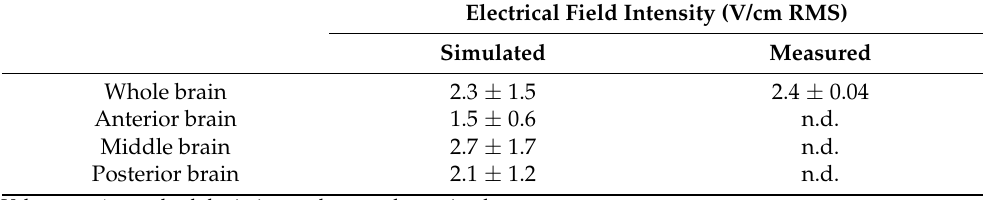
Table 1. Simulation and measurement of the electrical field intensity distribution of TTFields at 100 kHz within the rats’ brain.